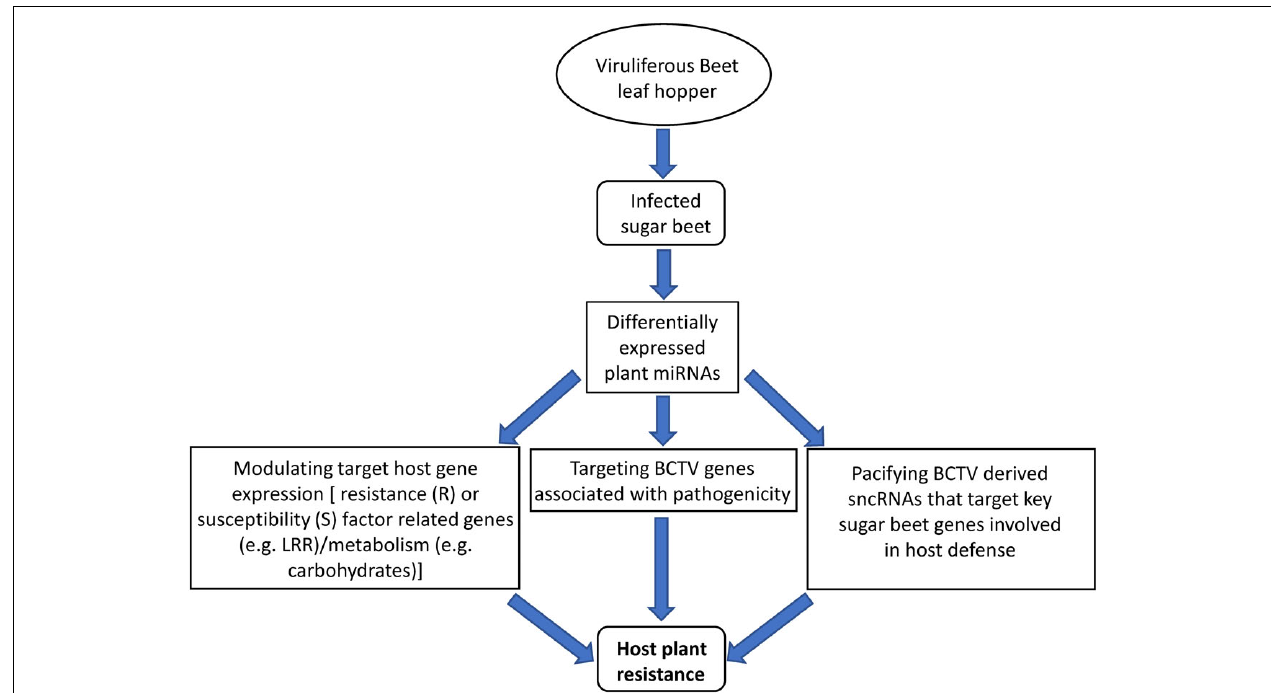
FIGURE 8 | Proposed model of miRNA mediated sugar beet resistance against BCTV in the resistant